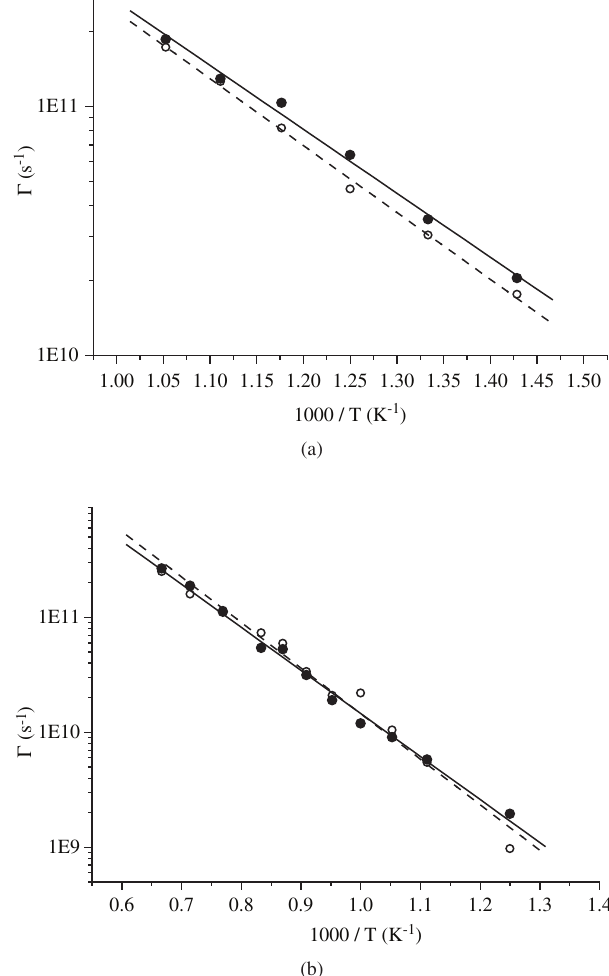
Figure 2. Temperature dependence of the jump